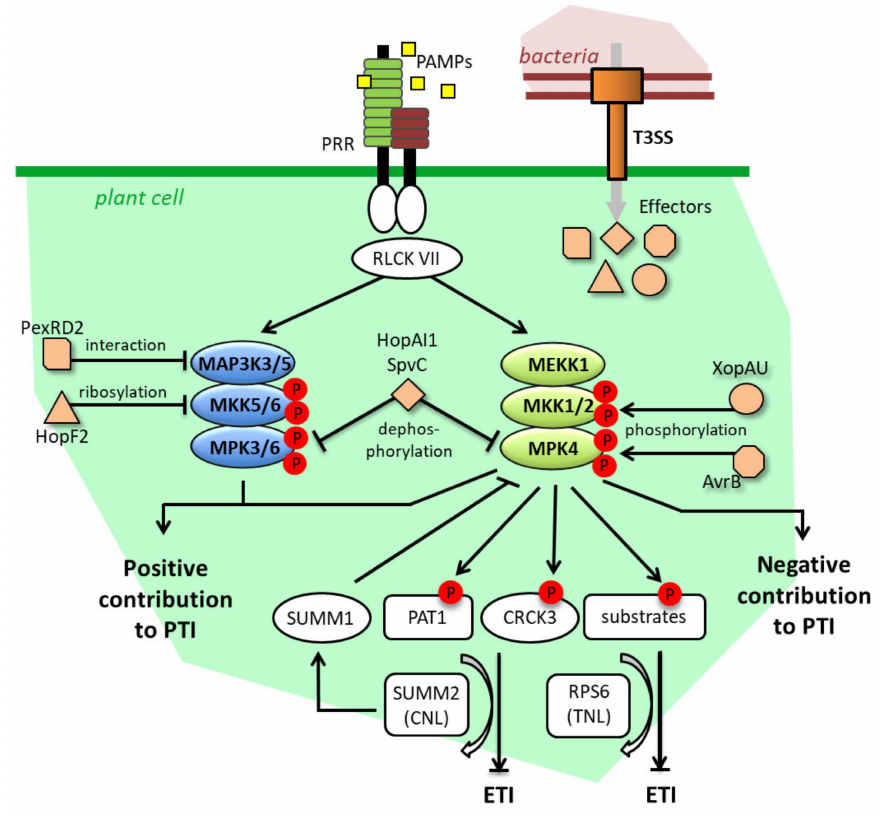
Figure 1. Pathogen e ff ector targeting and guarding mechanisms of MAPK signaling. E ff ectors target MAPK signaling at di ff erent levels and through di ff erent molecular